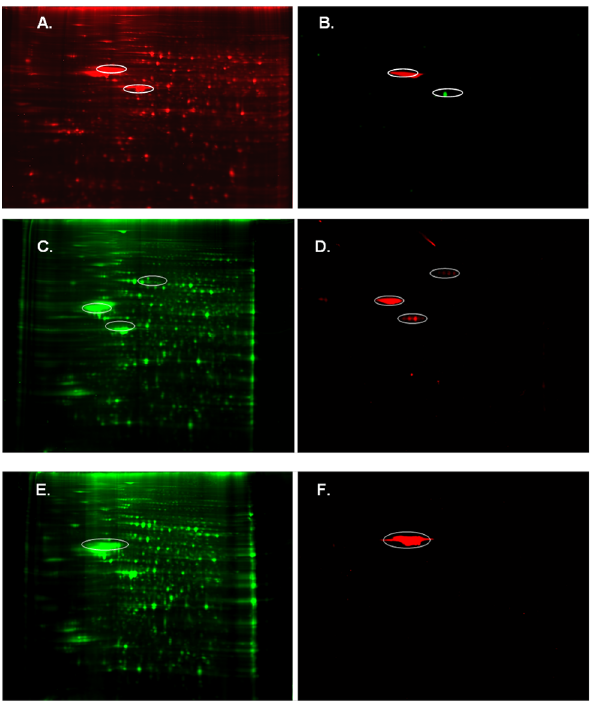
Figure 1. Actin and tubulin were phosphorylated after mood stabilizer treatment. A. 2D-DIGE gel image stained with Sypro Ruby stain showing phosphorylation of synaptoneurosomal preparations of saline treated animals (controls). B. location of actin identified spots (green spot) and tubulin (red spot) in saline treated preparations. C. Spots identified with actin antibodies during Western blots (circled) of synaptoneurosomal preparations after mood stabilizer treatment. D. Western blot identification of phosphorylated actin (circled). E. 2D-DIGE gel image showing phosphorylation after mood stabilizer treatment and the location of tubulin identified spots as indicated by circle. F. Spots identified with tubulin antibodies (circled).